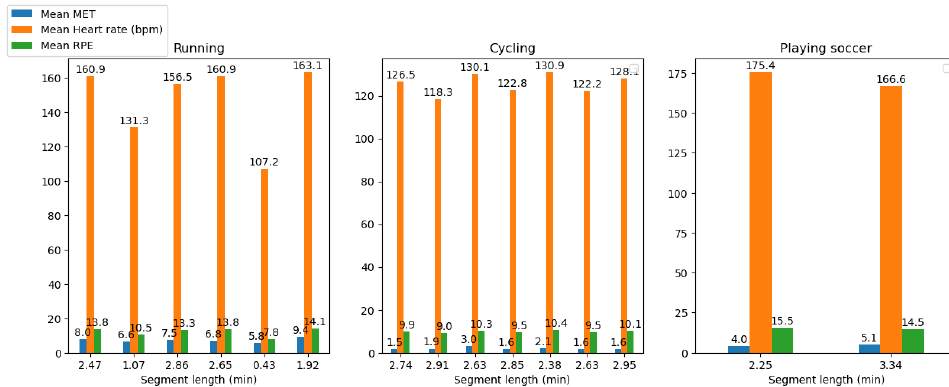
Figure 9. MET, HR, and RPE per sport on segments.